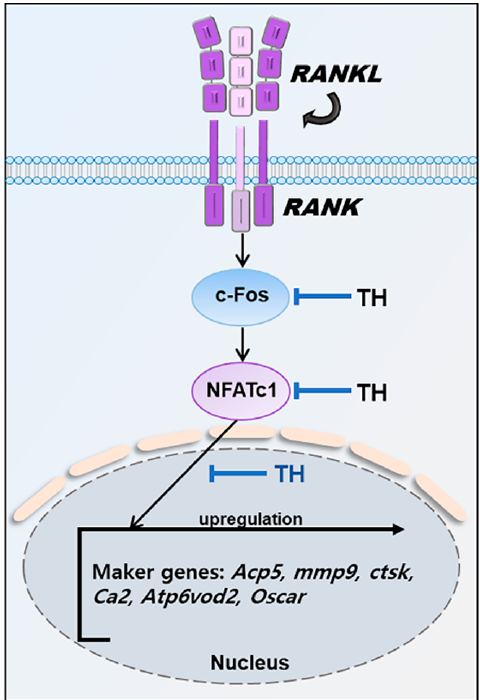
Figure 9. Mechanisms by which TH inhibits osteoclast differentiation.